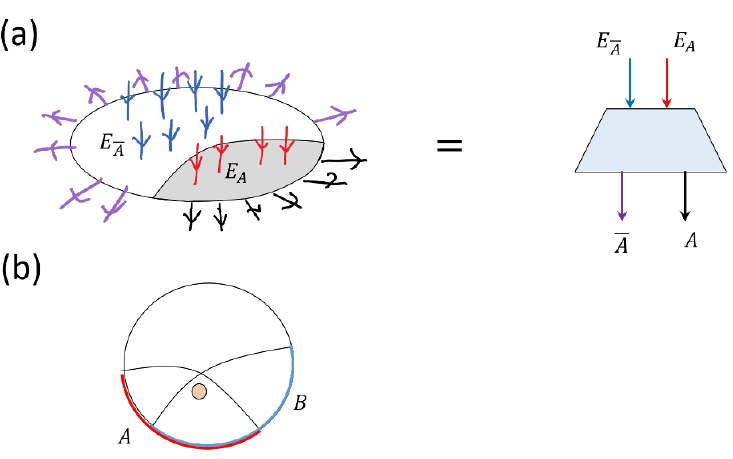
Figure 5 . (a) Illustration of the bulk-boundary map de(cid:12)ned in the code subspace. The mapping from the whole bulk subspace to the boundary is an isometry. Furthermore, the local reconstruction property requires that degrees of freedom in E which is the entanglement wedge of A can be A reconstructed in A , which means an isometry is de(cid:12)ned from E A to A for arbitrary states in E A and A . (b) A small region in the bulk (orange disk) can be reconstructed in di(cid:11)erent boundary regions such as A; B